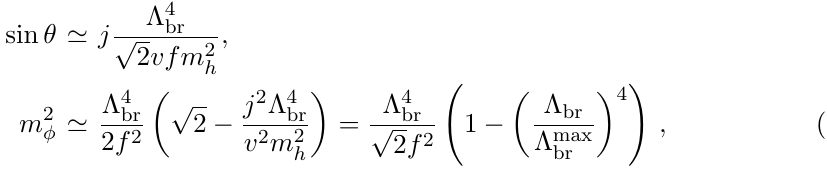
that maximizes m (cid:30) for each f . Here (cid:3) max br